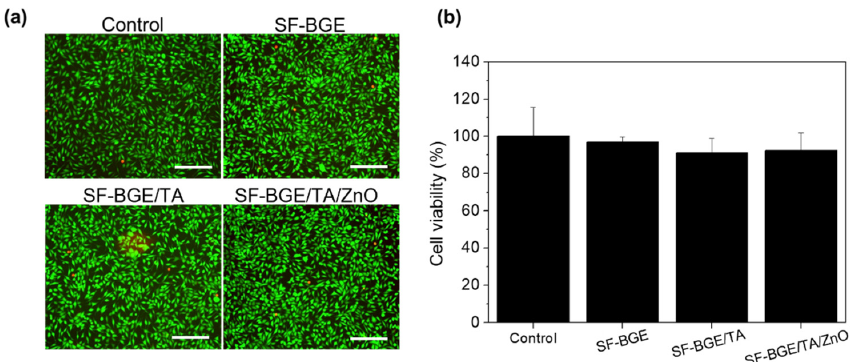
Figure 4. Indirect cytotoxicity test of SF-BGE, SF-BGE/TA, and SF-BGE/TA/ZnO samples on L929 fibroblast with ( a ) LIVE/DEAD staining (green: live, red: dead) and ( b ) cell viability (%) quantified based on the cell counting kit-8 (CCK-8) assay using extracts of SF-BGE and SF-BGE/TA solutions and SF-BGE/TA/ZnO hydrogel for 24 h. As a control, Dulbecco’s phosphate-buffered saline (DPBS) was used (inset scale bar is 200 µm). The data are expressed as the mean ± standard deviation (n = 3). All samples are not significantly different (per one-way analysis of variance (ANOVA) and Tukey’s post hoc test).